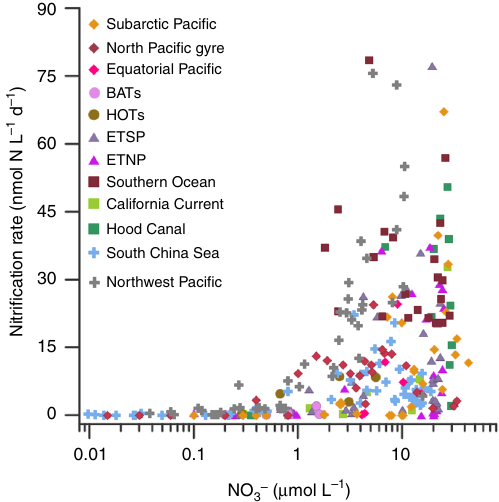
Fig. 4 Nitri fi cation rates versus NO 3 − concentrations in the upper 200 m of different ocean provinces. Data of Subarctic Paci fi c, North Paci fi c gyre, and Equatorial Paci fi c are from ref. 6 ; BATs from ref. 10 ; HOTs from ref. 4 ; ETSP from ref. 67 ; ETNP from ref. 66 ; Southern Ocean from ref. 69 ; California Current from ref. 24 ; Hood Canal from ref. 25 ; South China Sea and Northwest Paci fi c from this